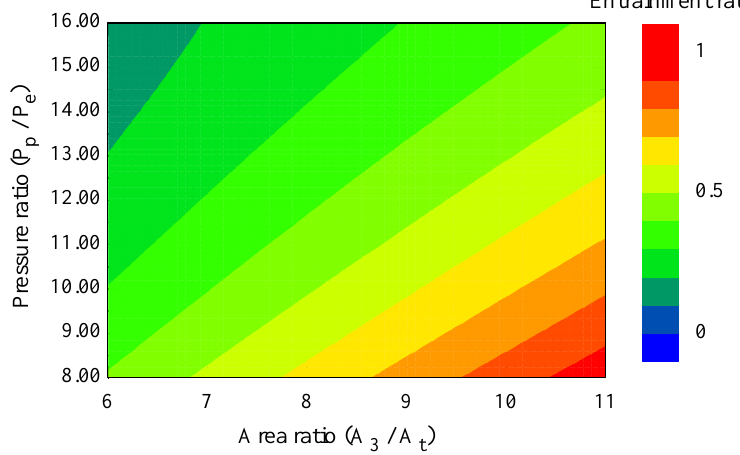
Figure 3. Relation between entrainment ratio ( ω ) with area ( A 3 / A t ) and pressure ratio ( P g / P e ). Energies 2020 , 13 , x FOR PEER REVIEW